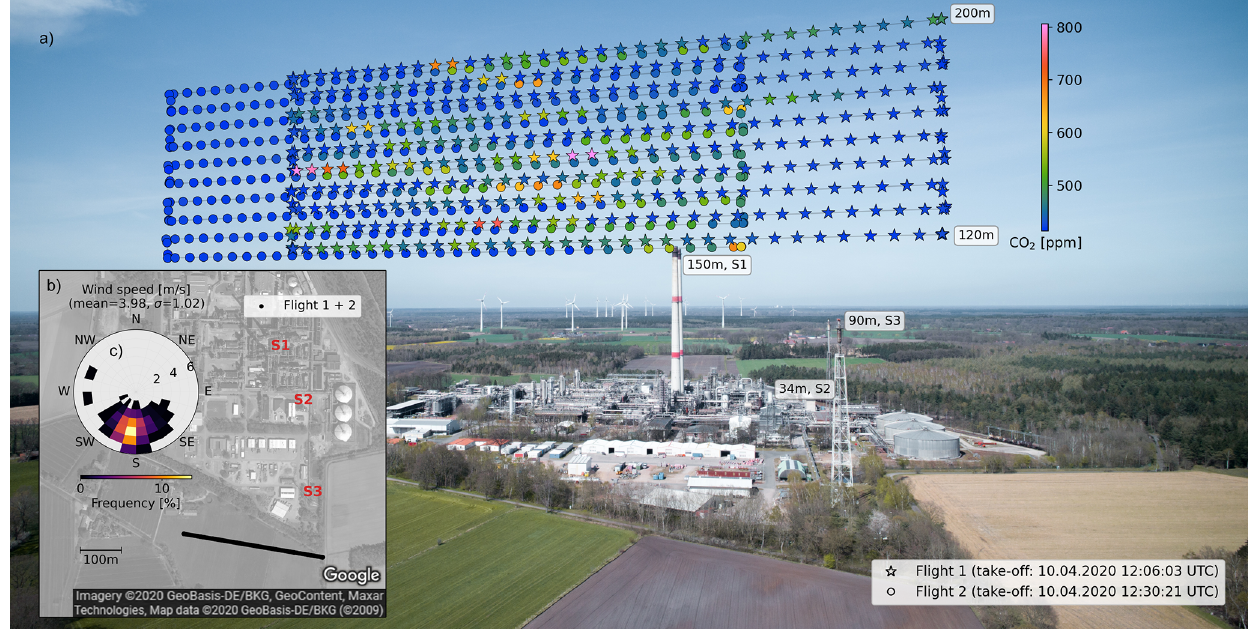
Figure 7. Overview of two flights downwind of the ExxonMobil natural gas processing facility in Großenkneten 40km west of Bremen, Germany, 10 April 2020. (a) CO 2 measurements of both flights projected onto an aerial photograph taken from a height of 80m. Note that only for the purpose of plotting, we added 3m to the altitudes of the first flight. (b) Top view of the measurement site including positions of the sources S1–S3, flight track, and histogram of wind speed and direction (c)